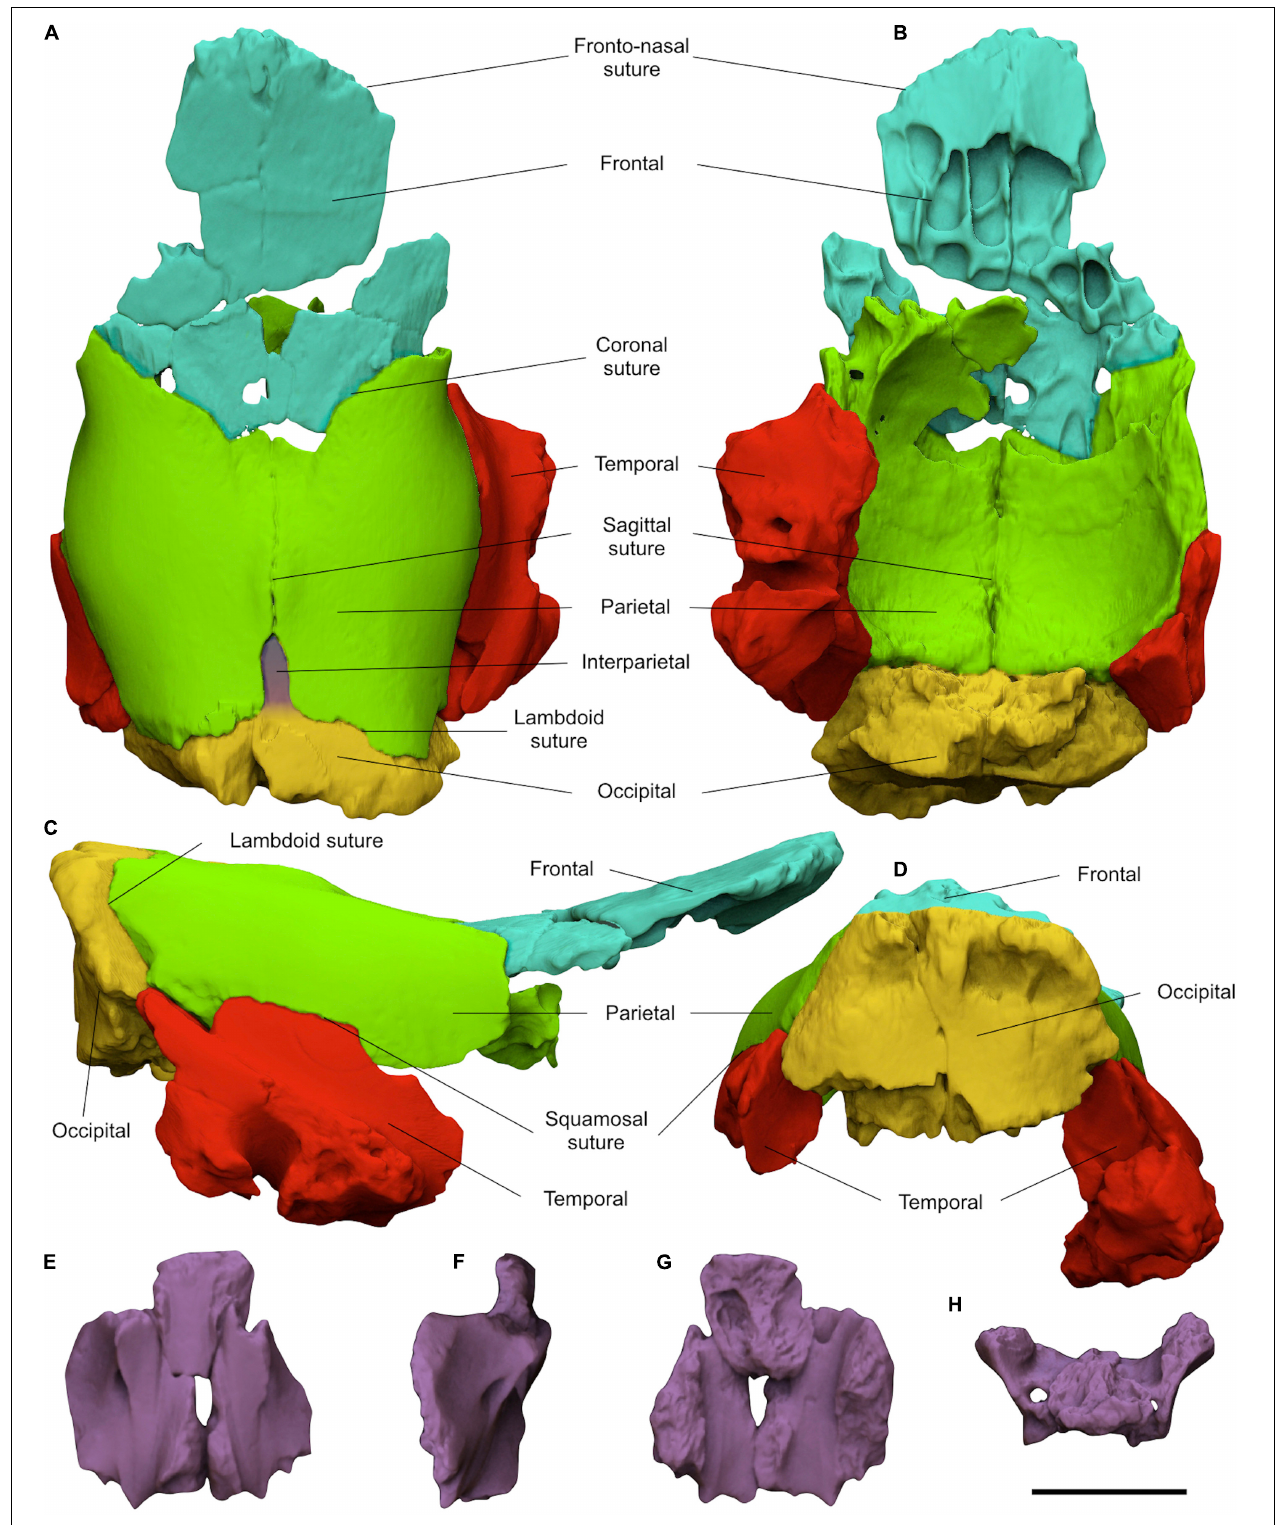
FIGURE 3 | Digitally restored braincase MPND1082 in dorsal (A) , ventral (B) , right lateral (C) , and occipital (D) views; reassembled basisphenoid in ventral (E) , right lateral (F) , dorsal (G) , and caudal (H) views. Scale bar 5 cm.